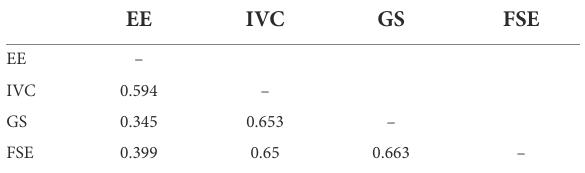
TABLE 6 Heterotrait-Monotrait ratio